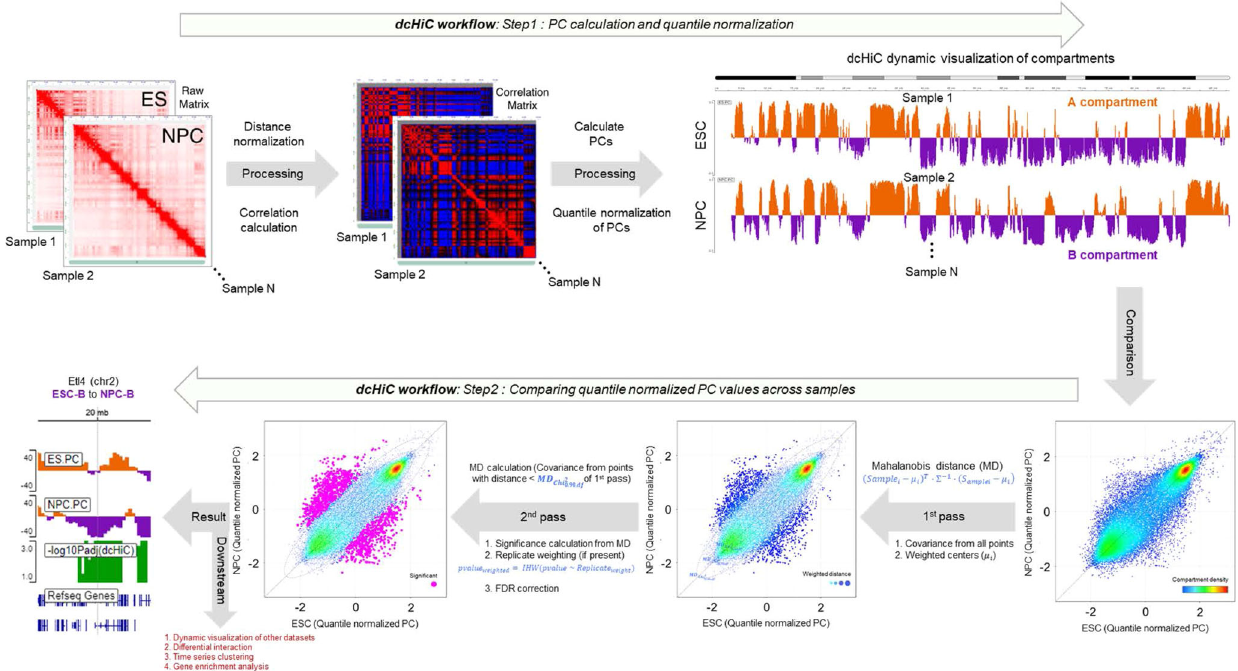
Fig. 1 | Outline of the method. The fi gure panel shows the dcHiC work fl ow in two steps.Instep1,dcHiCcalculatestheprincipalcomponentsfollowedbythequantile normalization of the compartment scores across all input Hi-C data. In step 2, for each genomic bin, dcHiC calculates the Mahalanobis distance, a multi-variate z- score that measures the extent to which each bin is an outlier with respect to the overall compartment score distribution across all input Hi-C maps (Methods - dif- ferential compartment identi fi cation). dcHiC then utilizes the Mahalanobis